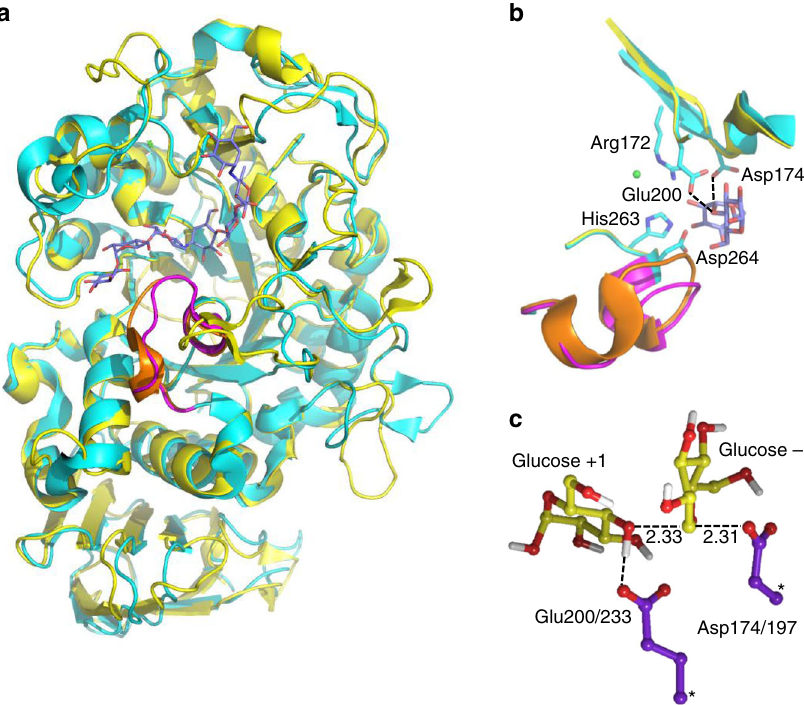
Fig. 1 Structures of the psychrophilic and mesophilic α -amylases and their active site. a View of the two enzymes (AHA in cyan and PPA in yellow) 36,38 with the bound substrate (blue carbons). The L7 loop partly covering the substrate is shown in purple for AHA and orange for PPA. b Close-up view of the active site with sidechains shown for AHA and the interactions between the nucleophile (Asp174) and general acid (Glu200) indicated with dashed lines (a crystallographically observed Cl − ion is shown in green). c Optimized transition-state structure from DFT calculations of the model reaction in solution (atoms marked with asterisks were fi